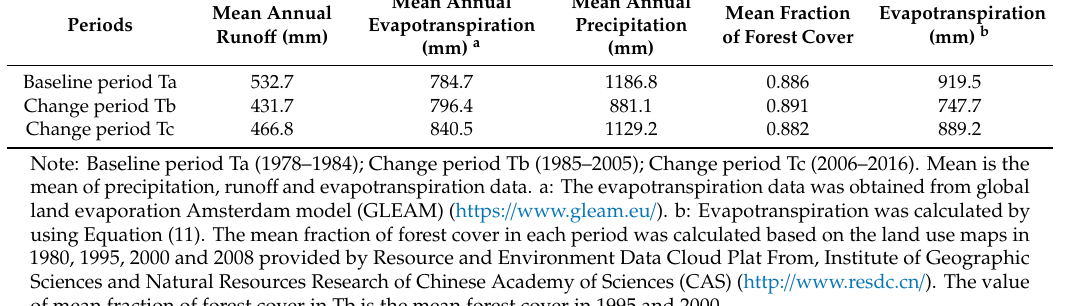
Table 3. Summary of the annual precipitation and runoff in different periods.